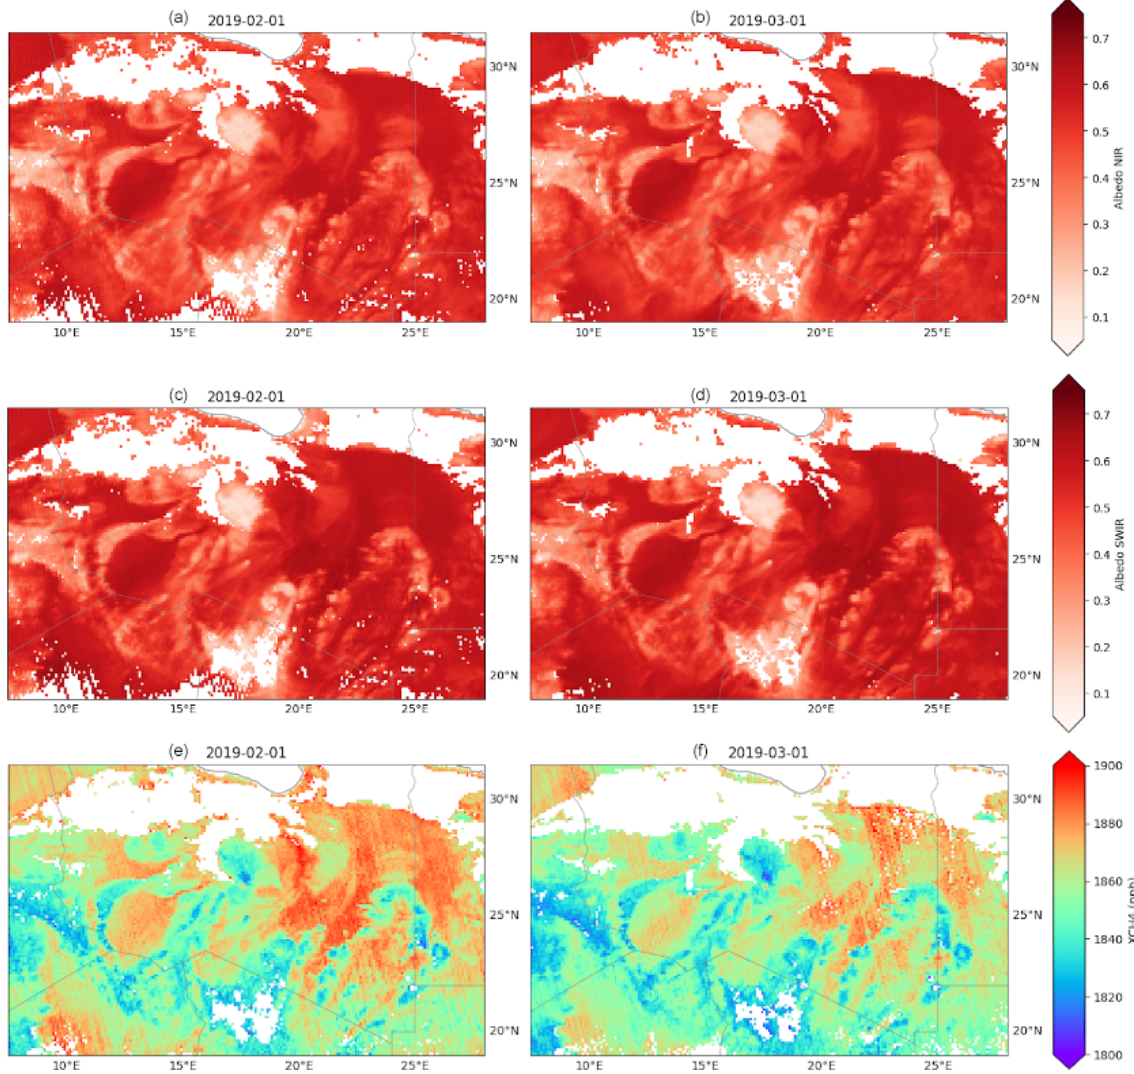
Figure 14. (a,b) TROPOMI albedo in the near-infrared (NIR) band, (c,d) TROPOMI albedo in the shortwave-infrared (SWIR) band, and (e,f) TROPOMI XCH 4 columns. Maps display averages for the same windows as shown in Fig.